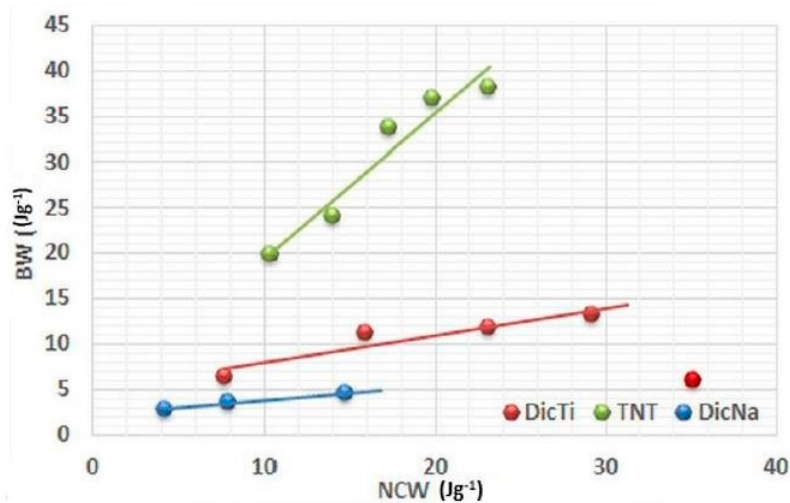
Figure 9. Evolution of breaking energy (BW) with NCW of TNT, DicNa and DicTi at 50, 100, 150, 200 and 250 MPa compression